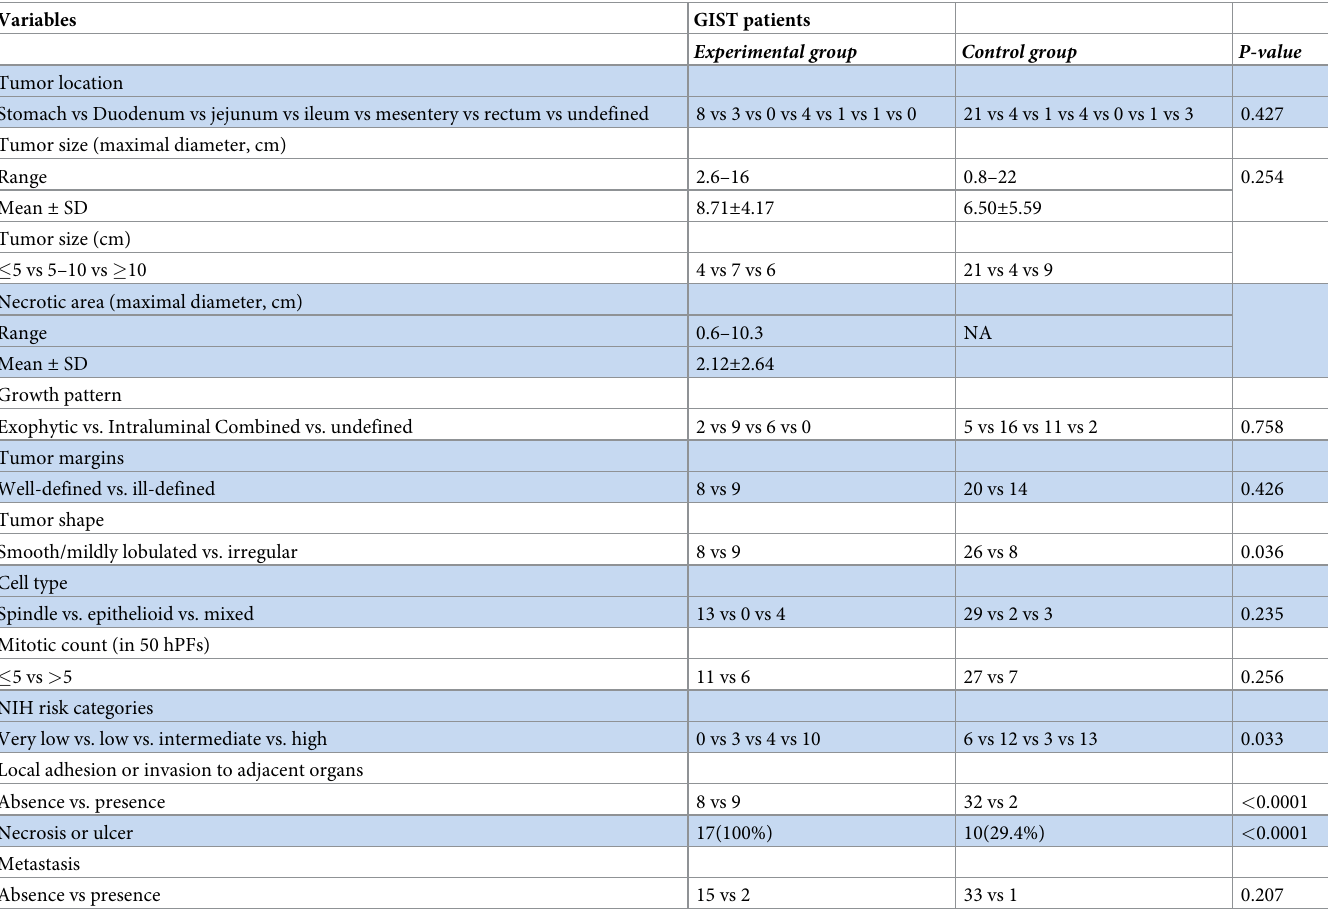
Table 2. Radiological and histopathological characteristics of GIST patients in the experimental group and control group. Variables GIST patients Experimental group Control